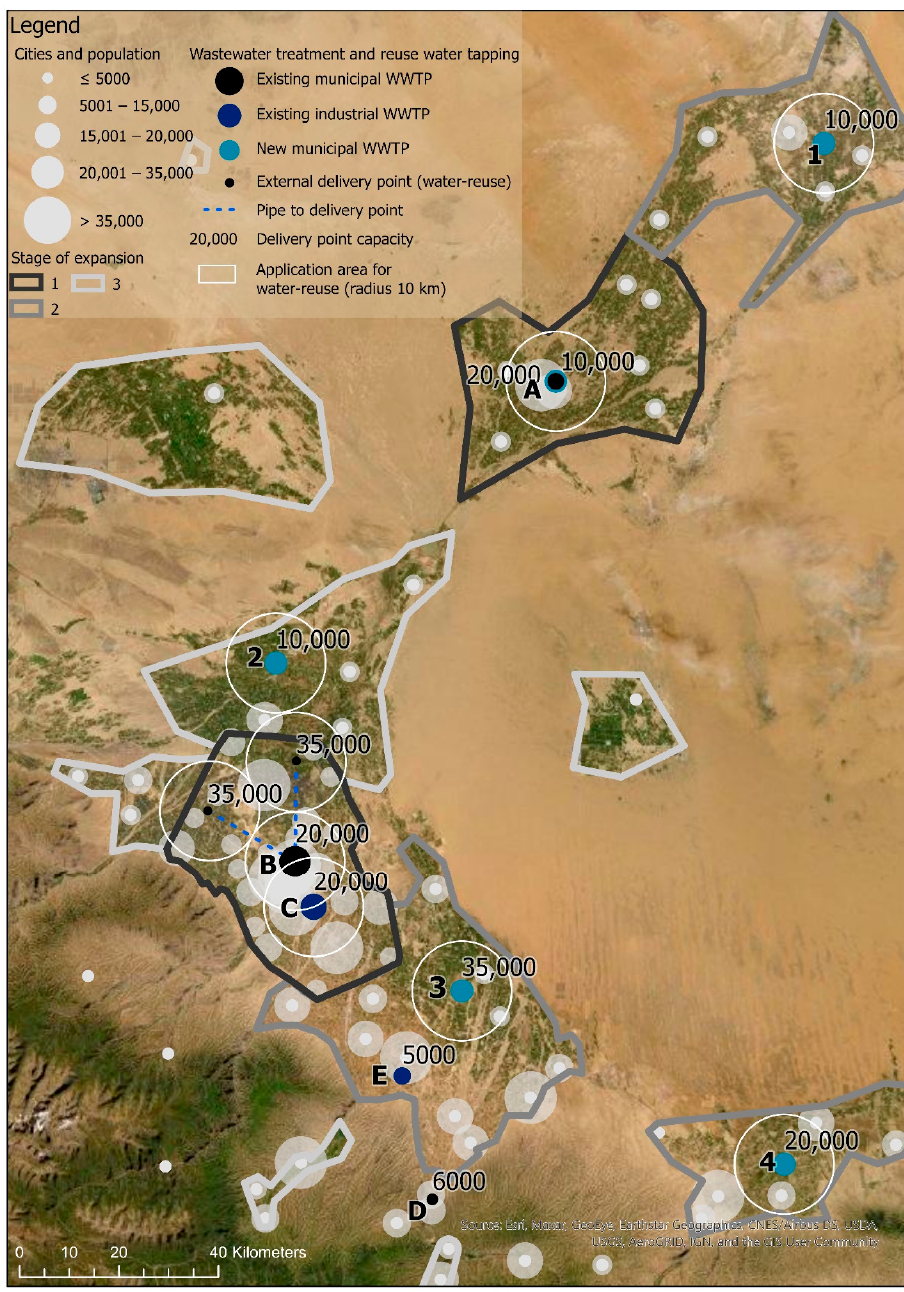
Figure 9. Water-reuse concept with recommended capacities for WWTPs and new delivery points.